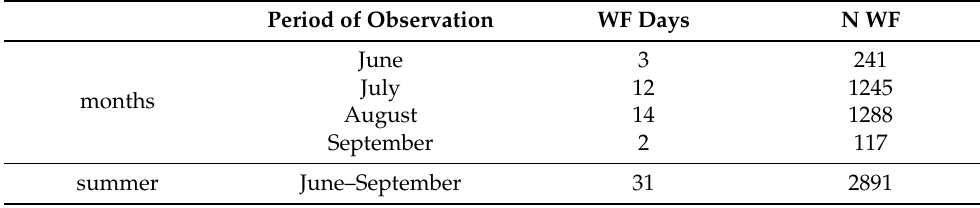
Table 1. Numbers of days with an identified wildfire influence (WF Days) and related numbers of wildfire detections (N WF) intercepted by ensemble WRF-HYSPLIT back-trajectories. Values are reported for each single month and for the whole summer